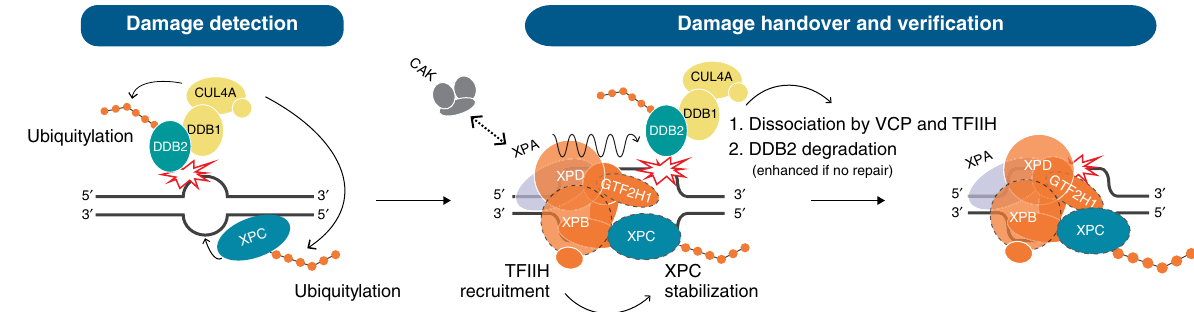
Fig. 7 Reciprocal coordination of DNA damage detection and handover in GG-NER. DDB2 binds directly to UV-photoproducts, thereby stimulating XPC recruitment to CPDs and 6-4PPs. The CRL4 E3 ubiquitin ligase is activated upon DDB2 binding and ubiquitylates DDB2 and XPC. TFIIH is recruited via an interaction between its subunit XPB with XPC (interaction depicted with dotted lines). Upon TFIIH binding, its trimeric CDK7-activating kinase (CAK) sub- complex is released and allows XPA binding, which further stimulates TFIIH ’ s XPD helicase that unwinds the DNA in the 5 ′ – 3 ′ direction while scanning for helicase blocking lesions. This con fi guration facilitates further interaction between TFIIH and XPC by allowing GTF2H1 to interact with XPC. Recruitment of TFIIH and ensuing damage veri fi cation promote the stable association of XPC with the undamaged strand and simultaneously facilitate the displacement of DDB2, which is also promoted by ubiquitylation-mediated extraction by VCP (1). The subsequent degradation of DDB2 (2) regulates its availability to rebind to lesions, possibly to avoid competition with the emerging NER pre-incision complex. The formation of a stable ternary XPC-TFIIH-XPA damage veri fi cation complex on the lesion and the unpaired DNA surrounding the lesion (created by this complex) provide substrate for the structure-speci fi c endonucleases XPF-ERRC1 and XPG (the latter coinciding with XPC dissociation), which completes the formation of the pre-incision